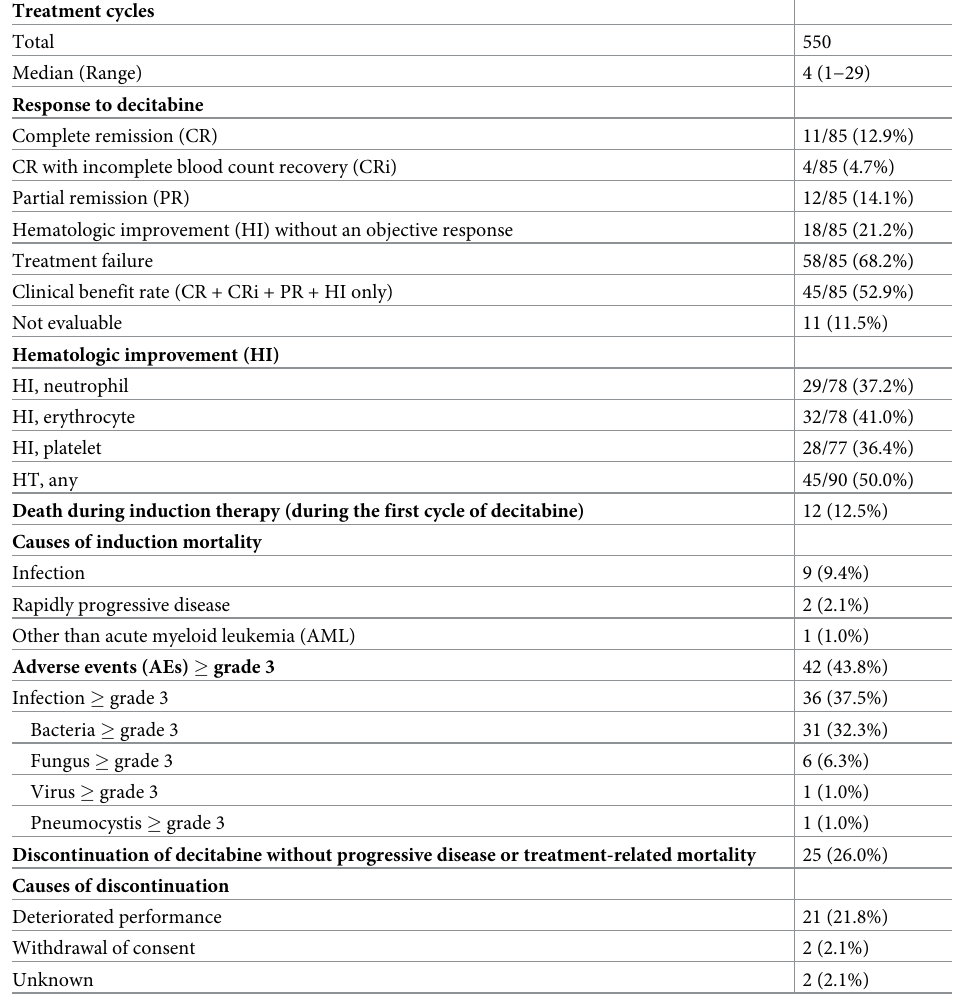
Table 2. Treatment outcomes and adverse